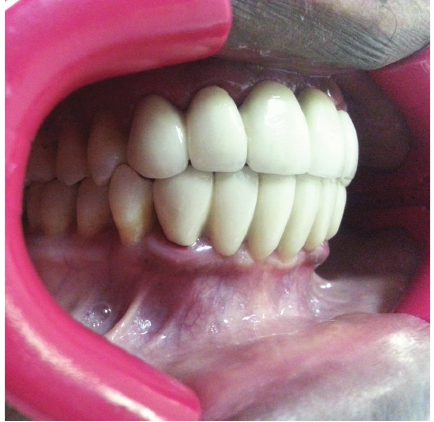
Figure 6: Final prosthesis.